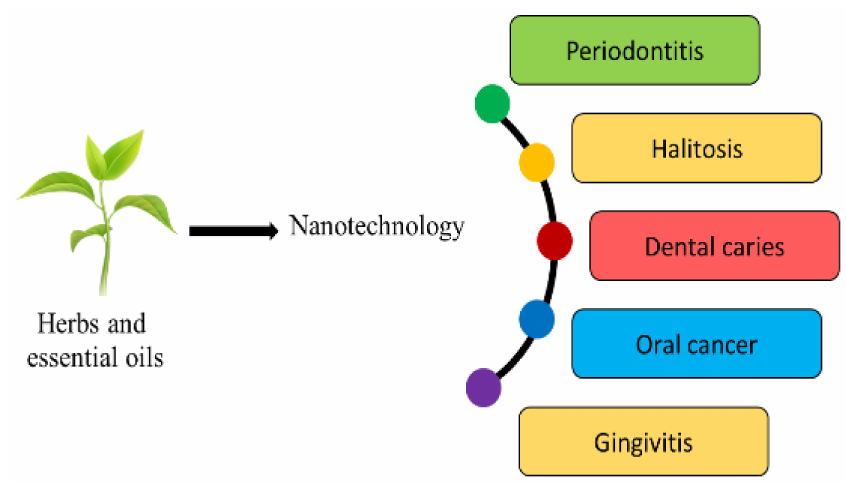
Figure 2. Applications of nano-herbal technology in diverse dental domains.